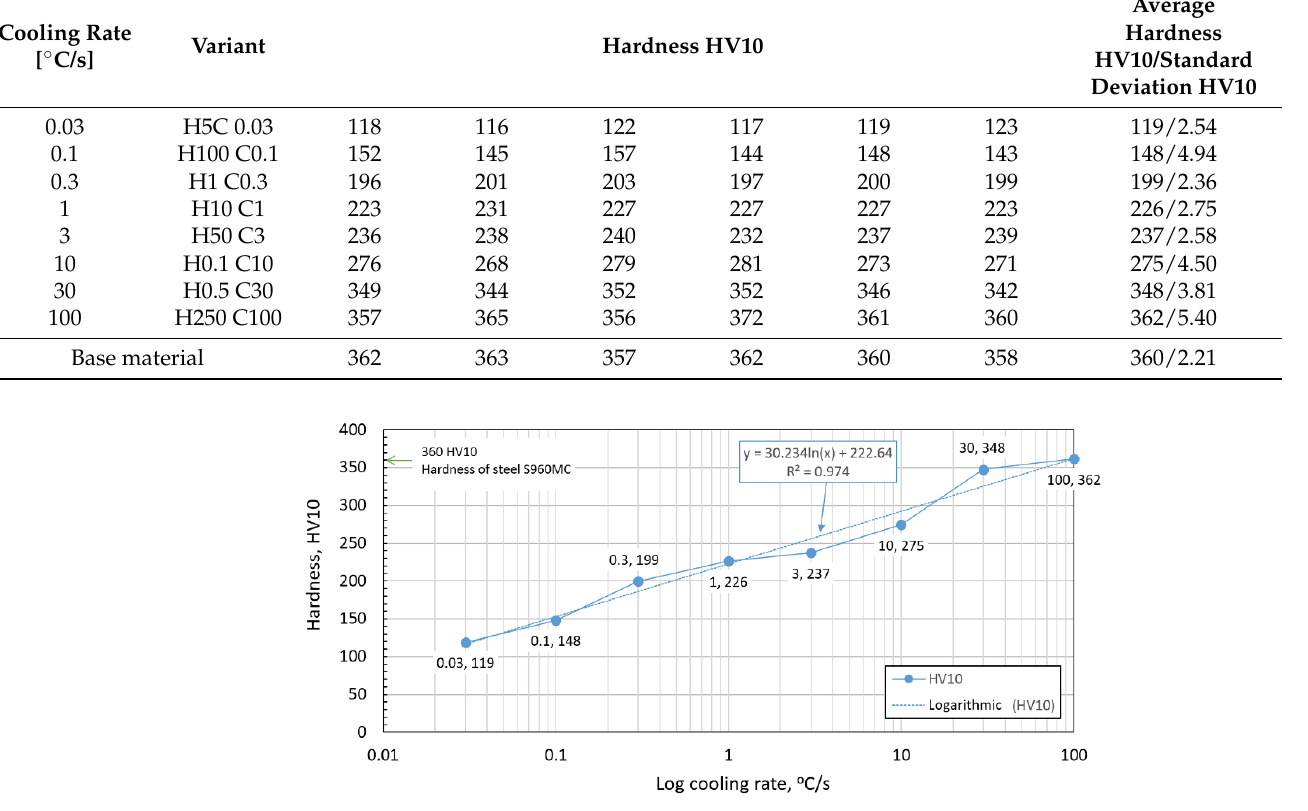
Figure 10. The influence of the cooling rate on material